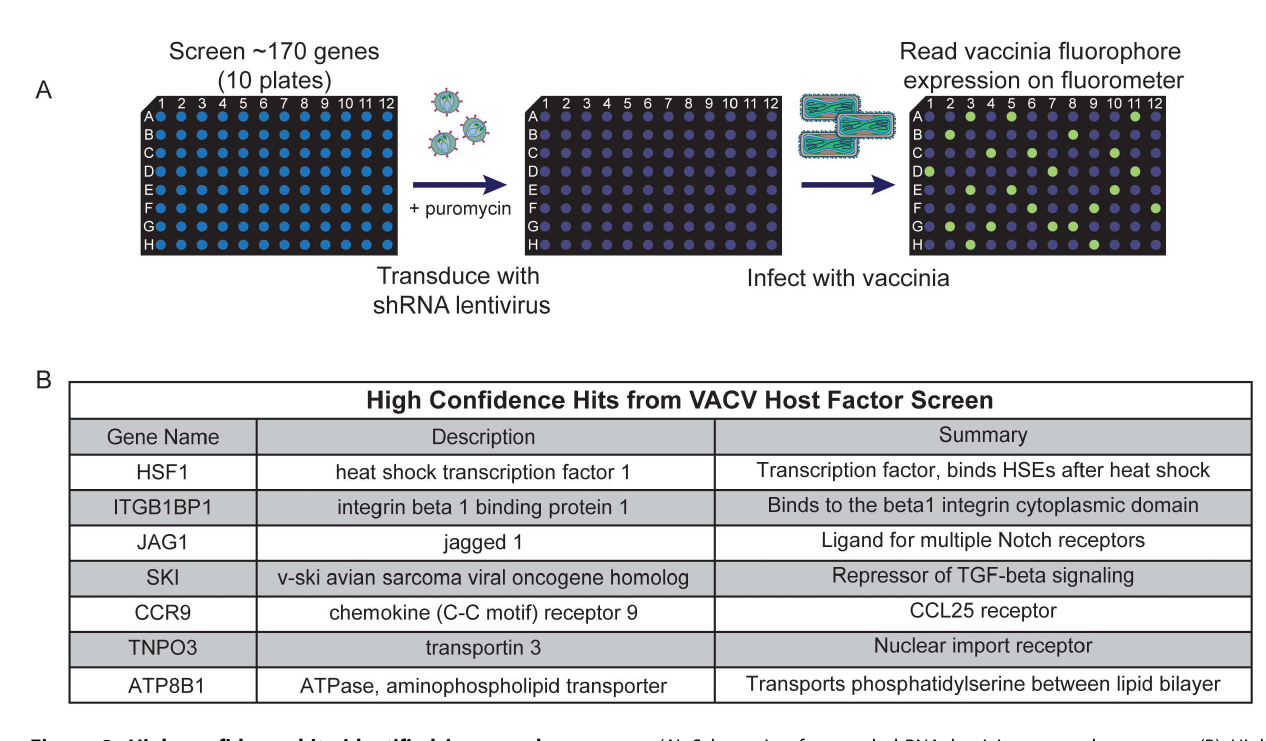
Figure 2. High confidence hits identified in secondary screen. (A) Schematic of arrayed shRNA lentivirus secondary screen. (B) High confidence host factor gene hits identified with the secondary screen.